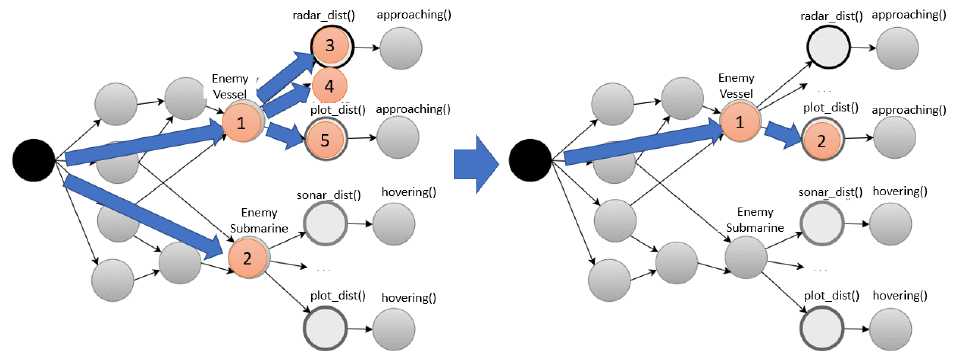
Figure 7. Hash indexing for beta nodes. Algorithm 2. Event Stabbing (e).